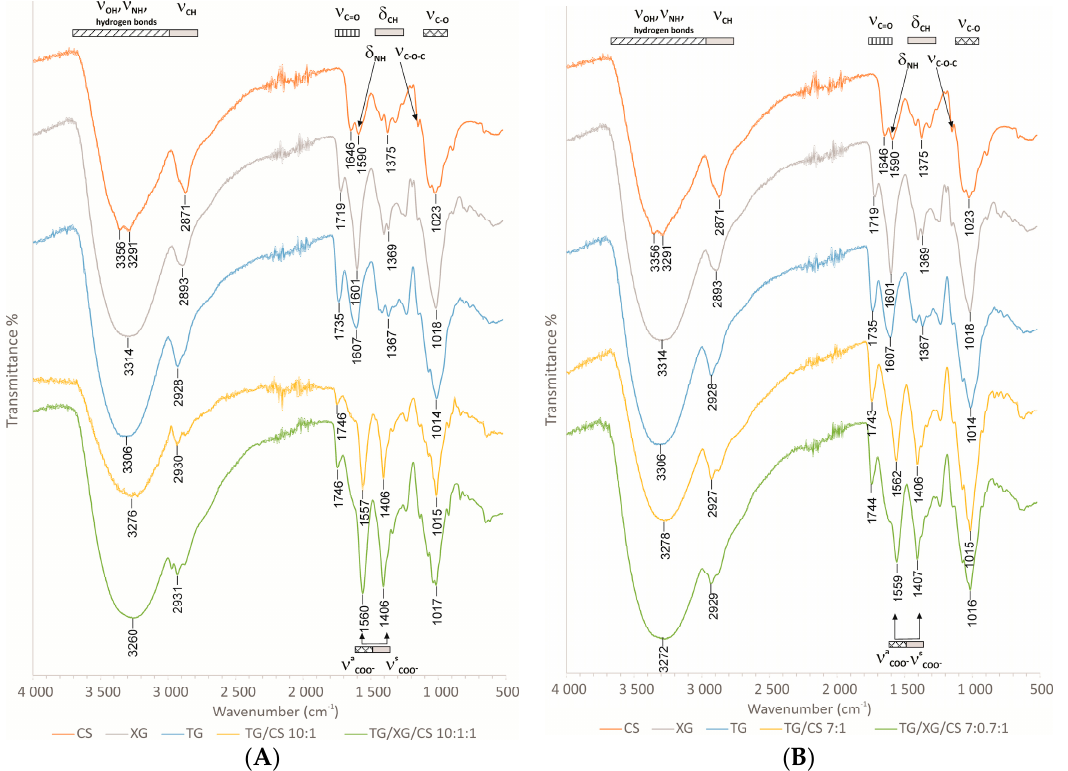
Figure 8. FTIR spectra of CS, TG, XG, di- (TG/CS 10:1 and TG/CS 7:1) and tripolymeric complexes (TG/XG/CS 10:1:1 and TG/XG/CS 7:1:1) ( A , B ) with different polymer ratios.